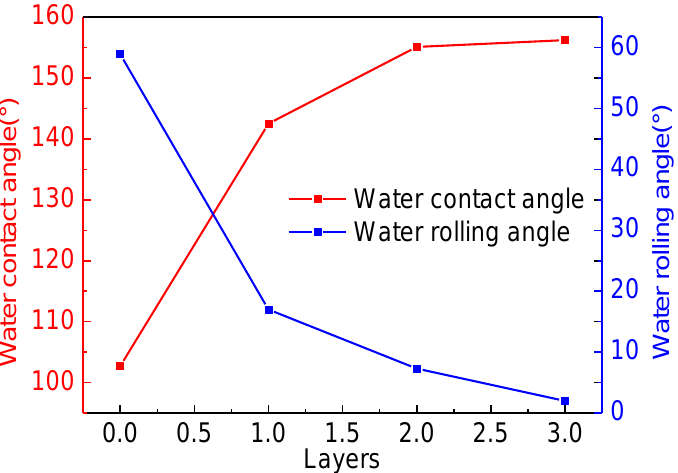
Figure 7. Water contact angle and water sliding angle of the filter film (400 meshes) with 0–3 layers.